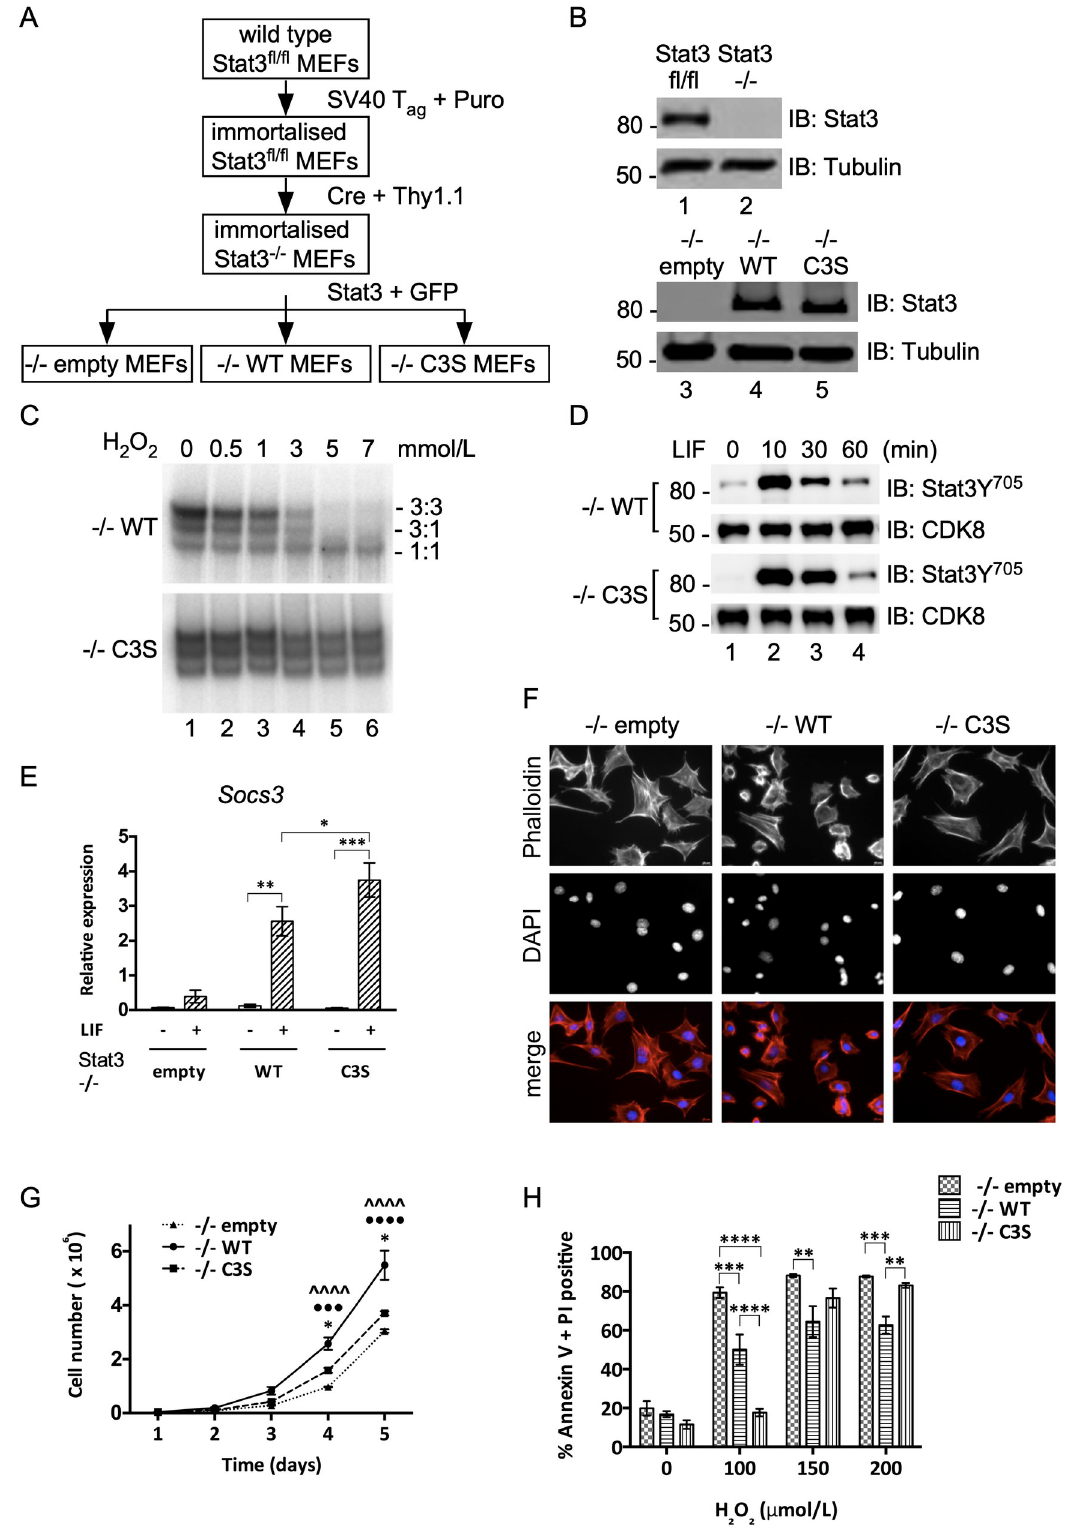
Fig 1. Generation and characterization of Stat3 cell lines. A) Flow diagram for the production of Stat3 null (-/-empty), WT-Stat3 (-/-WT) and redox-insensitive Stat3-C3S (-/-C3S) expressing MEFs. B) Upper: Immunoblot confirming Stat3 deletion